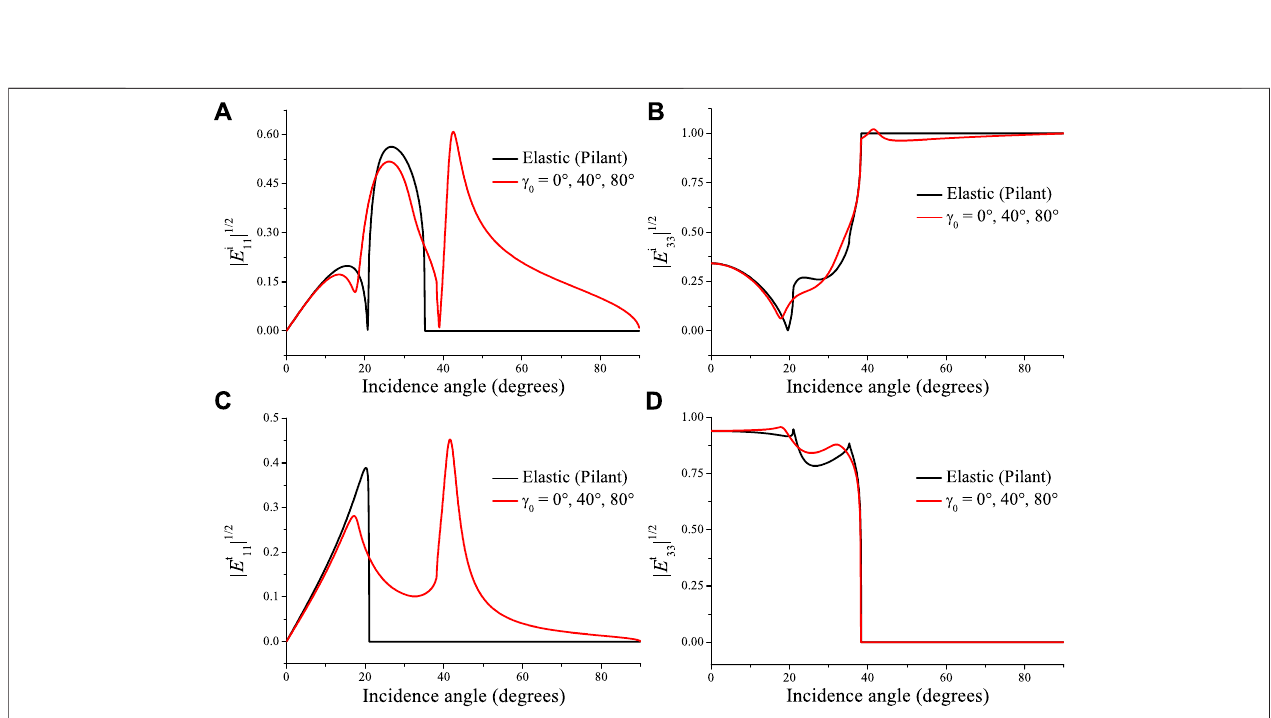
FIGURE 10 | Same as Figure 8 but for the square root of the energy ratios of the re fl ected P (A) , re fl ected S (B) , transmitted P (C) and transmitted S (D) waves, considering the fl ux in the z -direction.